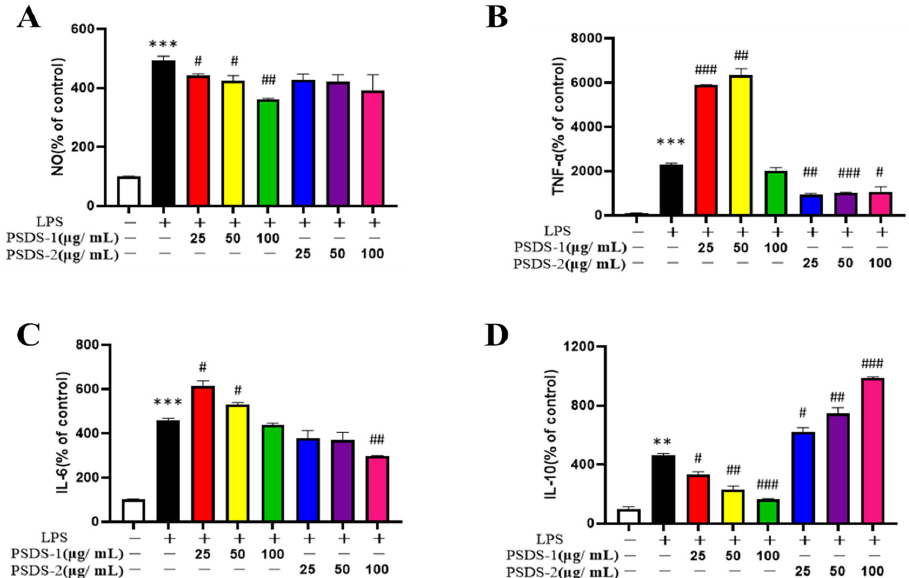
Figure 3. Effects of PSDSs-1 and PSDSs-2 on NO release in RAW264.7 cells ( A ); Effects of PSDS-1 and PSDSs-2 on ( B ) TNF- α production, ( C ) IL-6 production and ( D ) IL-10 production in RAW264.7 cells. ** p < 0.01, *** p < 0.001 compared with blank control group; # p < 0.05, ## p < 0.01 and ### p < 0.001 compared with LPS.